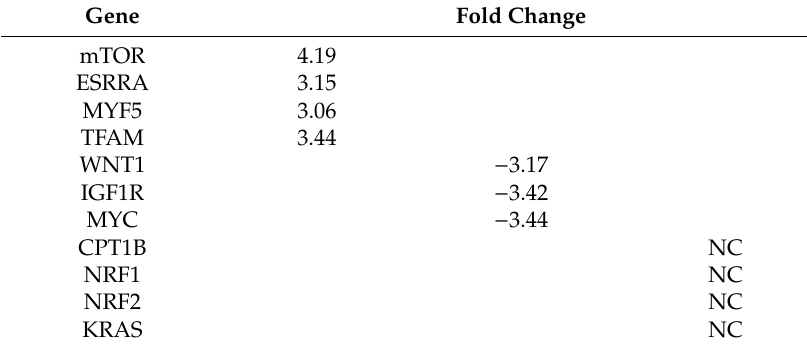
Table 1. Fold regulated gene expression of